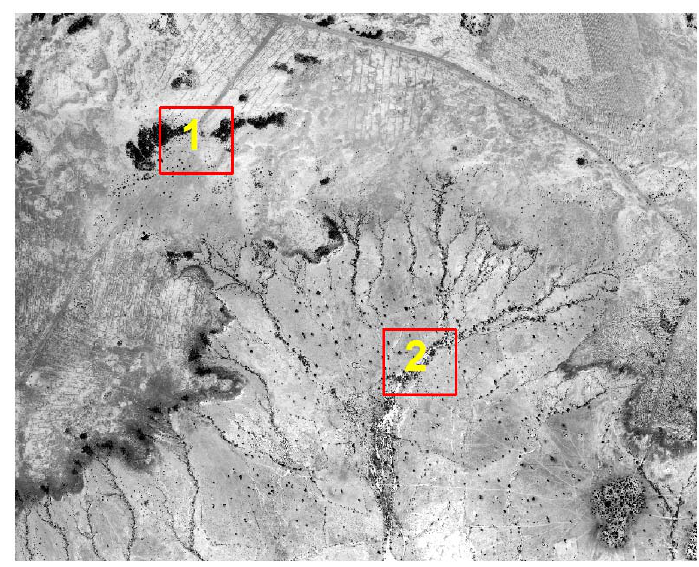
Figure 19. Ground truth sites. 1. Plateau 2. Drainage network. Kirib Kaina, 2010. Table 2. Error matrix analysis for two sites (on a pixel basis). Ground truth in columns, classification in rows. Kirib Kaina.